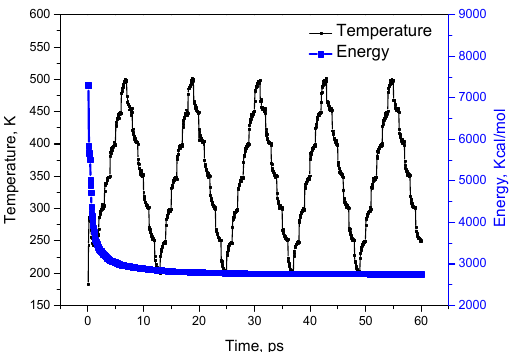
Figure 2. The change curves of system temperature and energy during the entire annealing process.